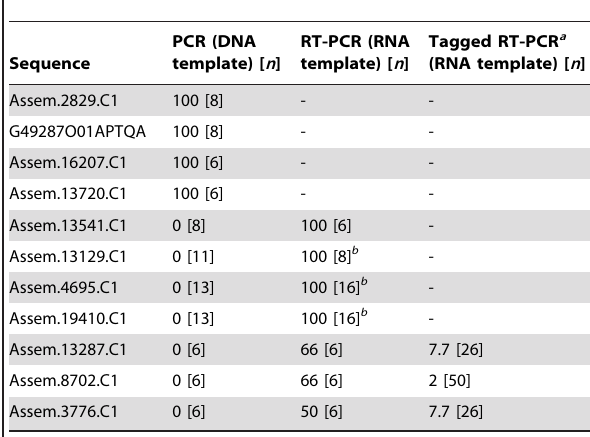
Table 3. Proportion of N. pubens field-collected colony samples producing an amplicon with oligonucleotide primers (see Table 1) designed to each sequence